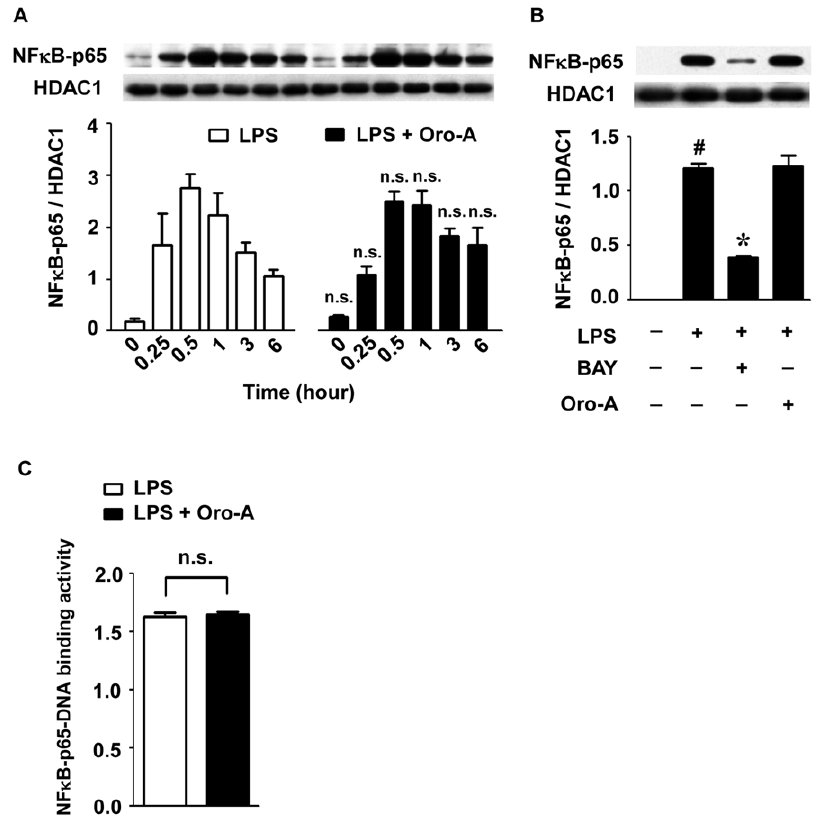
Figure 5. Failure of oroxylin A to inhibit LPS-induced activation of NF k B-p65 in BV-2 cells. ( A ) BV-2 cells (2 6 10 6 cells/dish) were incubated with LPS (100 ng/ml) and oroxylin A (Oro-A, 50 m M) for indicated time periods. Nuclear proteins were then isolated and examined by Western blot analysis using specific antibodies against NF k B-p65 and HDAC1. HDAC1 is used as nuclear internal control here. A representative Western blot for NF k B-p65 and HDAC1 is shown in upper panel. The ratio of NF k B-p65 to HDAC1 is calculated and shown in bottom panel. ( B ) Cells (2 6 10 6 cells/dish) were incubated with a NF k B inhibitor, BAY 11-7082 (BAY, 5 m M), or oroxylin A (Oro-A, 50 m M) in the presence of LPS (100 ng/ml) for 30 minutes. Nuclear proteins were then isolated and examined by Western blot analysis using specific antibodies against NF k B-p65 and HDAC1. A representative Western blot for NF k B-p65 and HDAC1 is shown in upper panel. The ratio of NF k B-p65 to HDAC1 is showed in bottom panel. ( C ) Cells (2 6 10 6 cells/dish) were exposed to LPS (100 ng/ml) and oroxylin A (50 m M) for 30 minutes. Nuclear proteins were then isolated and subjected to transcription factor DNA-binding activity assay. All results are expressed as means 6 SEM from three independent experiments. n.s., not significant, compared with LPS-treated cells. # , p , 0.05, one-way ANOVA followed by Tukey’s post hoc test compared with vehicle-treated cells; * , p , 0.05, one- way ANOVA followed by Tukey’s post hoc test compared with LPS-treated cells.